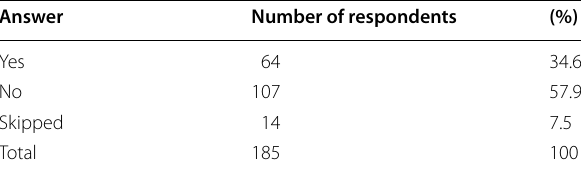
Table 10 Experience of 185 respondents with AI-based algorithms for clinical diagnostic interpretive tasks: Was the use of an AI software to reach the diagnosis mentioned in the report?